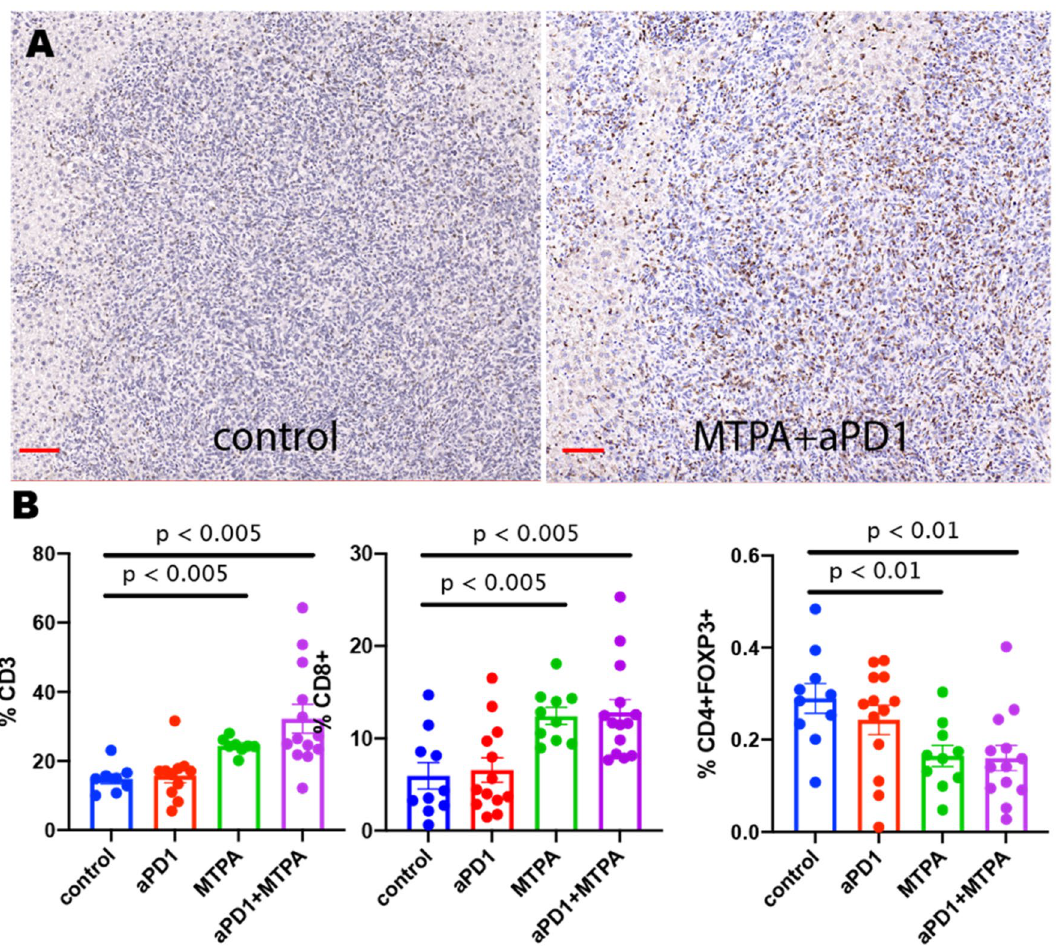
Figure 4. Immunohistochemical analysis of orthotopic HCC tumors treated with MTPA. MTPA was performed in an orthotopic mouse model of HCC with underlying cirrhosis. ( A ) IHC of CD8+ cells demonstrates minimal infiltrating T cells in control tumors but a substantial increase following anti-PD1 therapy combined with MTPA (red bar = 100 mm). ( B ) Quantitative analysis of IHC data (error bars reflect standard error) reveals a significant increase in intratumoral CD3+ and CD8+ T cells following MTPA alone and MTPA+anti-PD1 therapy, along with a decrease in CD4+FOXP3+ T regs . Percentages in panel B reflect the proportion of positively stained cells within a region of interest circumscribing the tumor. Box plots reflect mean +/− standard error. The non-parametric Mann–Whitney U-test was used to evaluate differences in the proportions across treatment